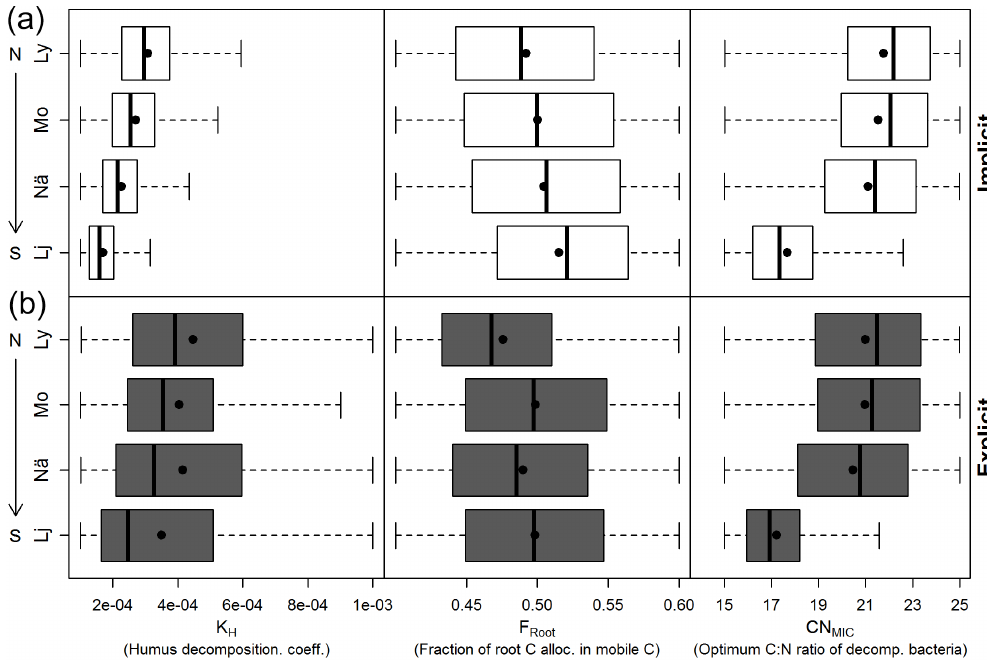
Figure 7. Posterior parameter distributions for common parameters using the implicit ( a : white) and explicit ( b : black) ECM approaches for four different sites from north to south. Distributions are presented as box plots over the prior range of variation (corresponding to the range on the x axis). Box plots depict the median (bold line), the 25th and 75th percentiles (bars), and the 10th and 90th percentiles (whiskers). The parameters shown are K H the humus decomposition coefficient, F Root the fraction of C assimilates distributed to the roots, ECM, and CN MIC the microbial C / N